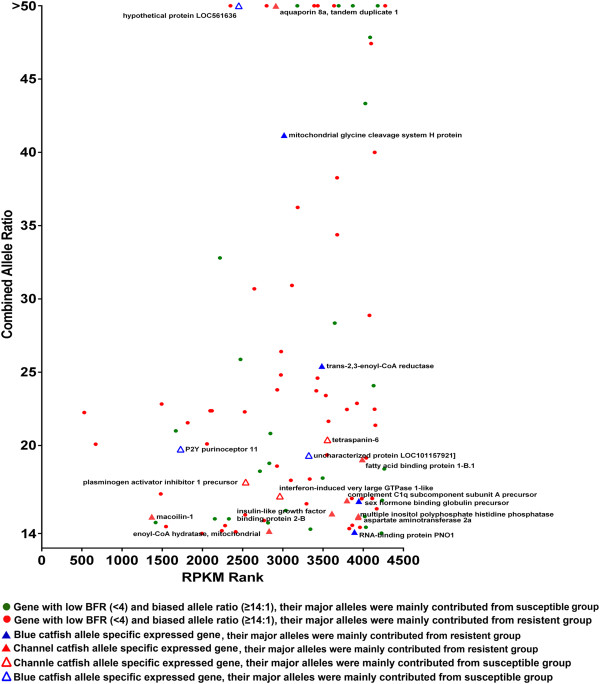
Genes harbouring significant SNPs, plotted by their combined allele ratios versus the rank of RPKM. Red dots stand for genes with the preferentially expressed allele expressed higher in resistant group and their parental origin unknown; Solid red triangles stand for genes with the preferentially expressed allele expressed higher in resistant group and their parental origin being channel catfish; Unfilled red triangles stand for genes with the preferentially expressed allele expressed higher in susceptible group and their parental origin being channel catfish; Solid blue triangles stand for genes with the preferentially expressed allele expressed higher in resistant group and their parental origin being blue catfish; Unfilled blue triangles stand for genes with the preferentially expressed allele expressed higher in susceptible group and their parental origin being blue catfish; and green dots stand for genes with the preferentially expressed allele expressed higher in susceptible group and their parental origin unknown.